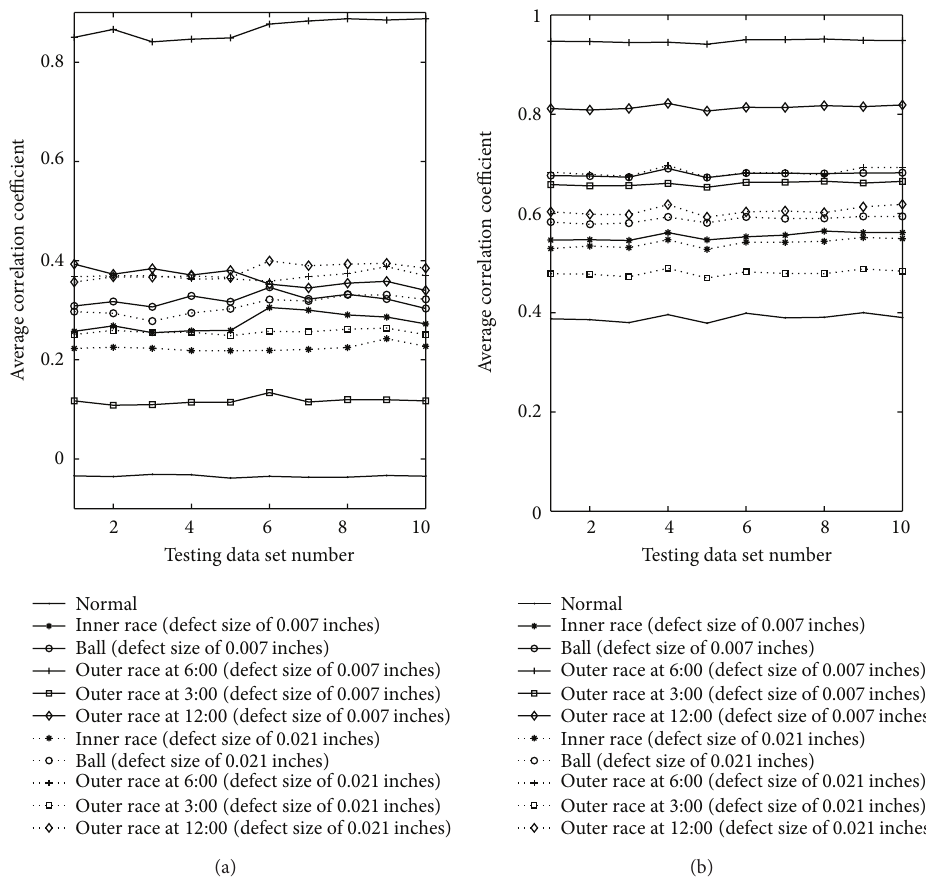
Figure 15: Detection of outer race fault at 6:00 with defect size of 0.007 inches according to morphology spectrum correlation analysis: (a) signal based triangular SE; (b) flat